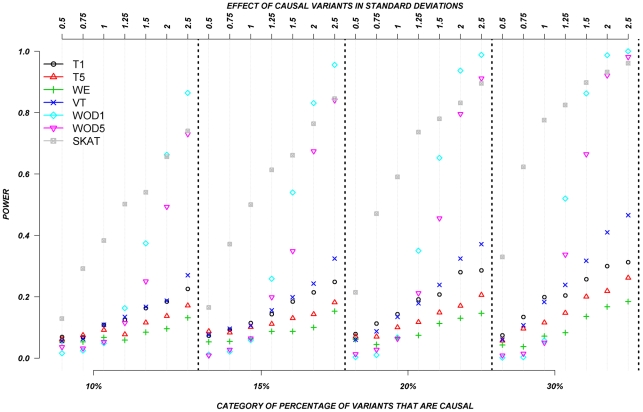
Continuous traits: Relationship between effect size, proportion of causal variants, and power, when causal variants are a mixture of protective and deleterious effects.Each box corresponds to a different proportion of causal variants involved in the relationship between rare variants and continuous traits (from left to right, 10, 15, 20 and 30%). On the x-axis, effect sizes are in standard deviations and correspond to the absolute value of the average size effect.